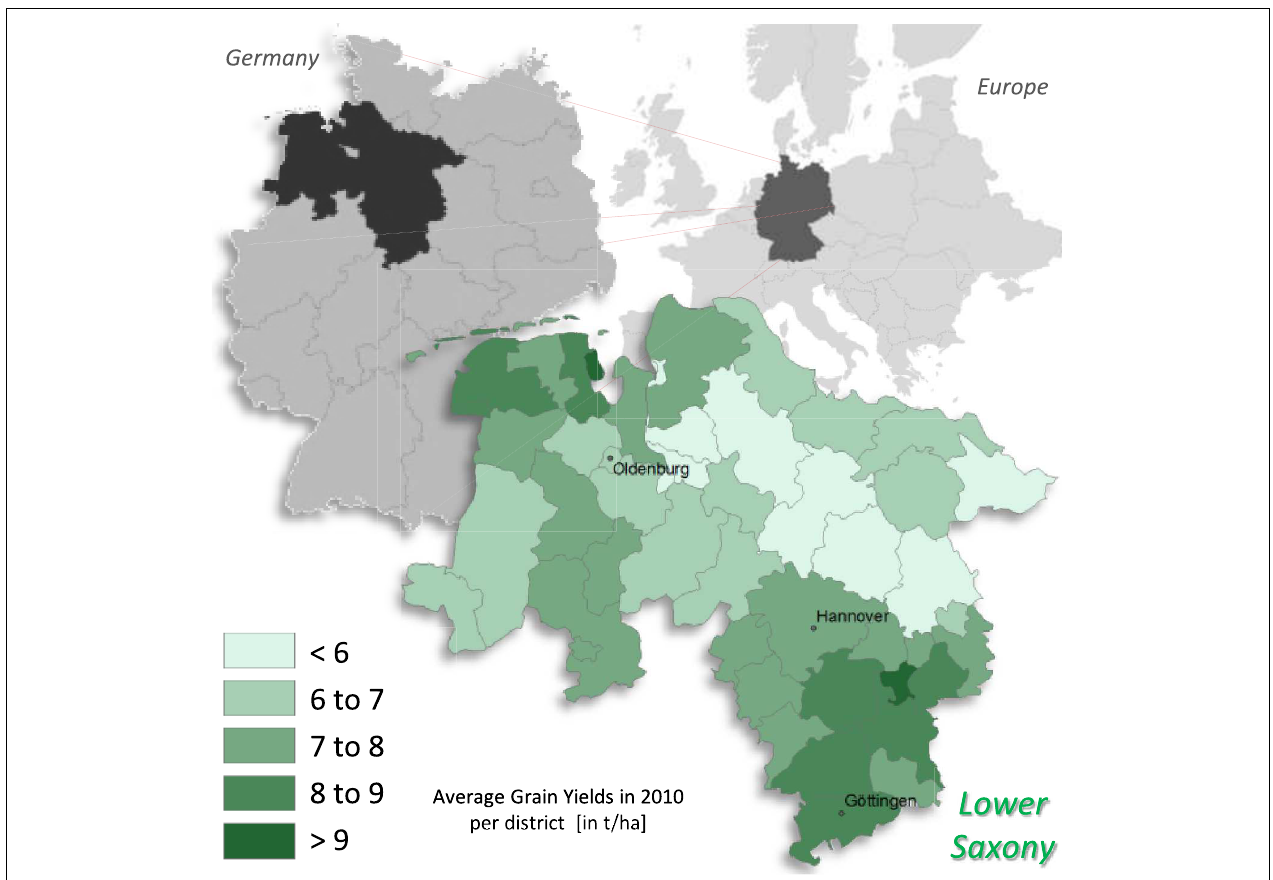
FIGURE 1 | The Research Area Niedersachsen. Displayed are the average yields of all grains for the year 2010 by district in t/ha (LSN, 2014).